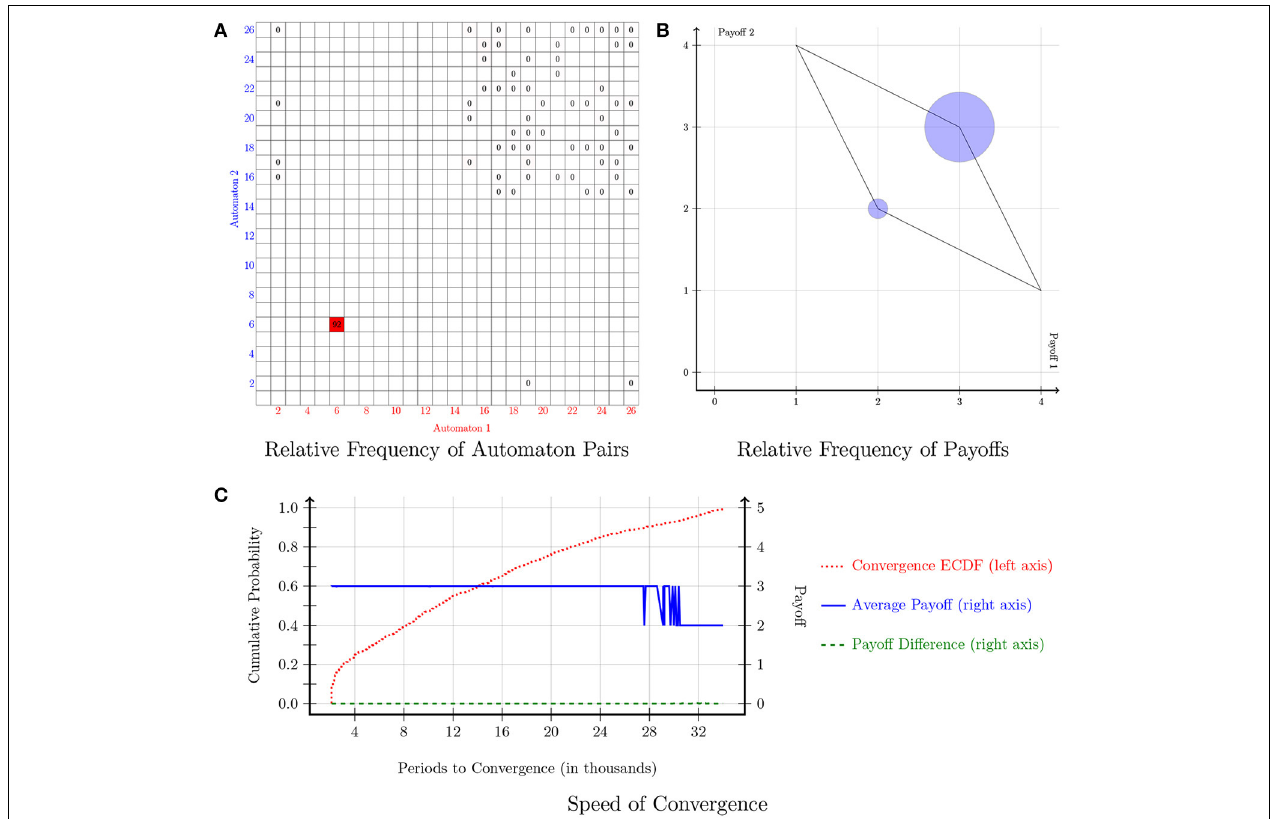
√ RF r = 2 , where RF is the relative frequency. Note that this is a concave function which emphasizes points with small relative frequency. (C) Provides information on the speed of convergence. The left axis indicates the probability and the red dotted line denotes the Empirical Cumulative Distribution Function (ECDF) for convergence. On the other hand, the blue solid line and the green dashed line correspond to the right axis and provide information on the payoffs of the automaton pairs when averaged over the last 1000 periods. The blue solid line represents the average payoff of the automaton pair ( g 1 + g 2 2 ). The green dashed line represents the absolute payoff difference of the automaton pair ( | g 1 − g 2 | ). Points on the blue solid and the green dashed line are sorted according to the corresponding point on the red dotted line.